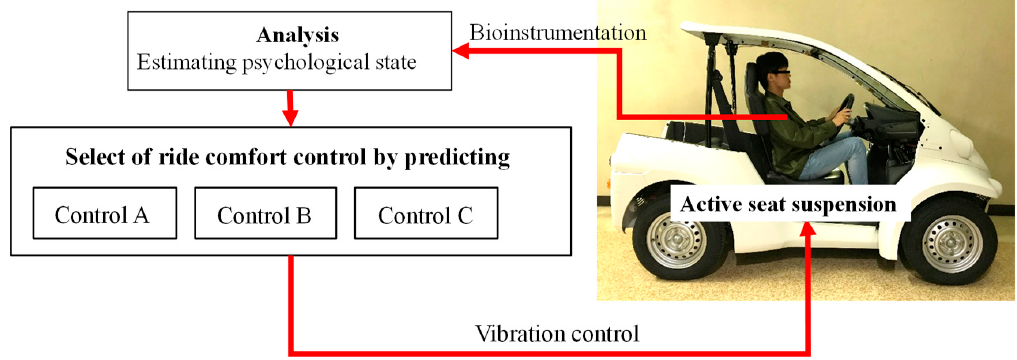
Figure 1. Proposed ride control system.